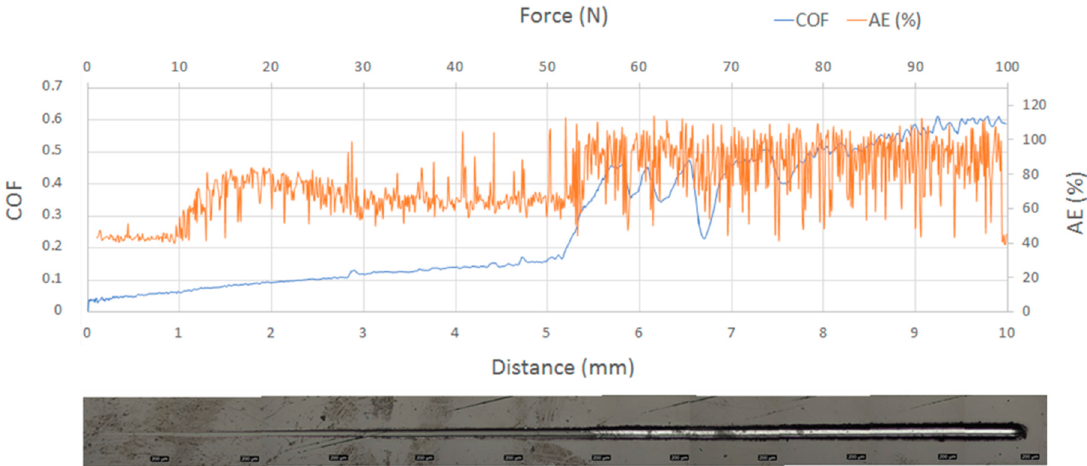
Figure 8. Nanoscratch test for WC:C coating. Evolution of the coefficient of friction (COF, blue plot) and the acoustic emission (AE, orange plot) vs. the indenter displacement, and optical micrograph of the scratch tracks.